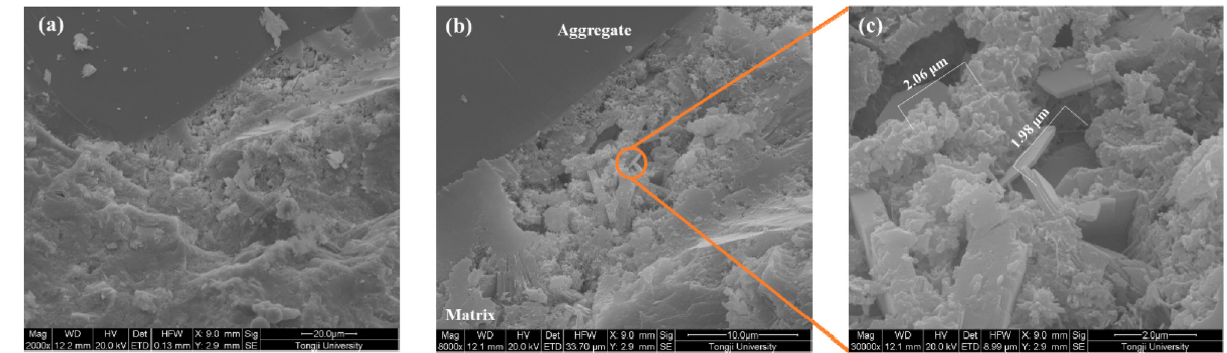
Figure 3: SEM image of ITZ in concrete. ( a ) 2000 × ; ( b ) 8000 × ; ( c ) 30000 × [ 34 ] .